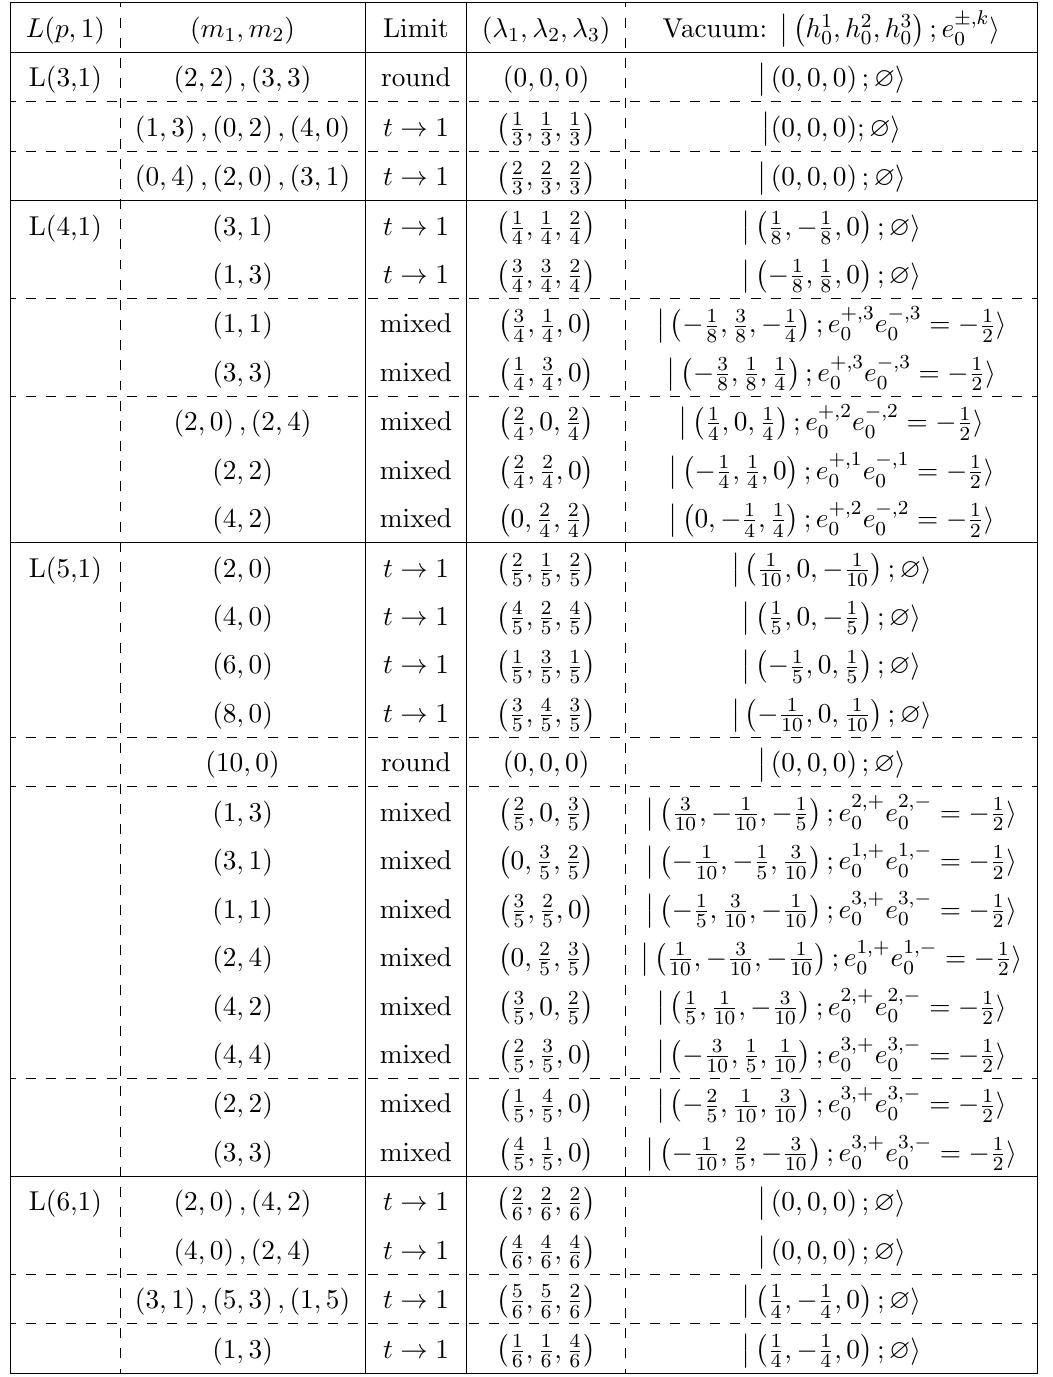
Table 6 . We list here examples of the lens index of the ( A 1 ; D 4 ) Argyres-Douglas theory for a few value of r , and their precise identi(cid:12)cation with the twisted chiral algebra of columns list the lens index data. We then specify the correct limit in the third column, which allows one to precisely match to a twisted character with ( (cid:21) 1 ; (cid:21) 2 ; (cid:21) 3 ) | as given in the fourth column | and the vacuum/highest-weight prescription in the (cid:12)nal